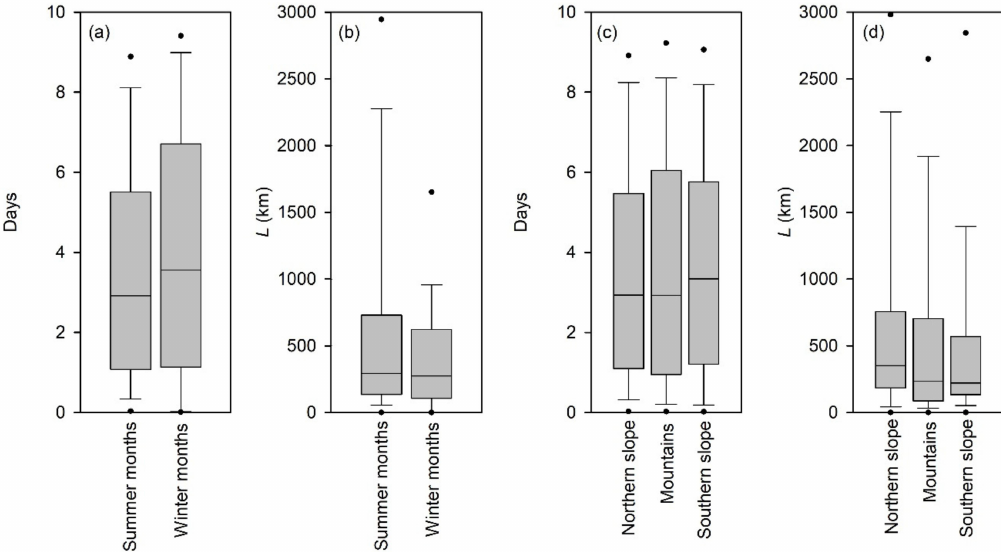
Figure 5. Transport time in days ( a and c ) and distances ( b and d ) of the backward trajectories between moisture source and sampling site around the Tianshan Mountains. The bottom of the box indicates the 25th percentile, a line within marks the median, and the top of box indicates the 75th percentile; whiskers indicate the 90th / 10th percentiles; the points above and below show 95th / 5th